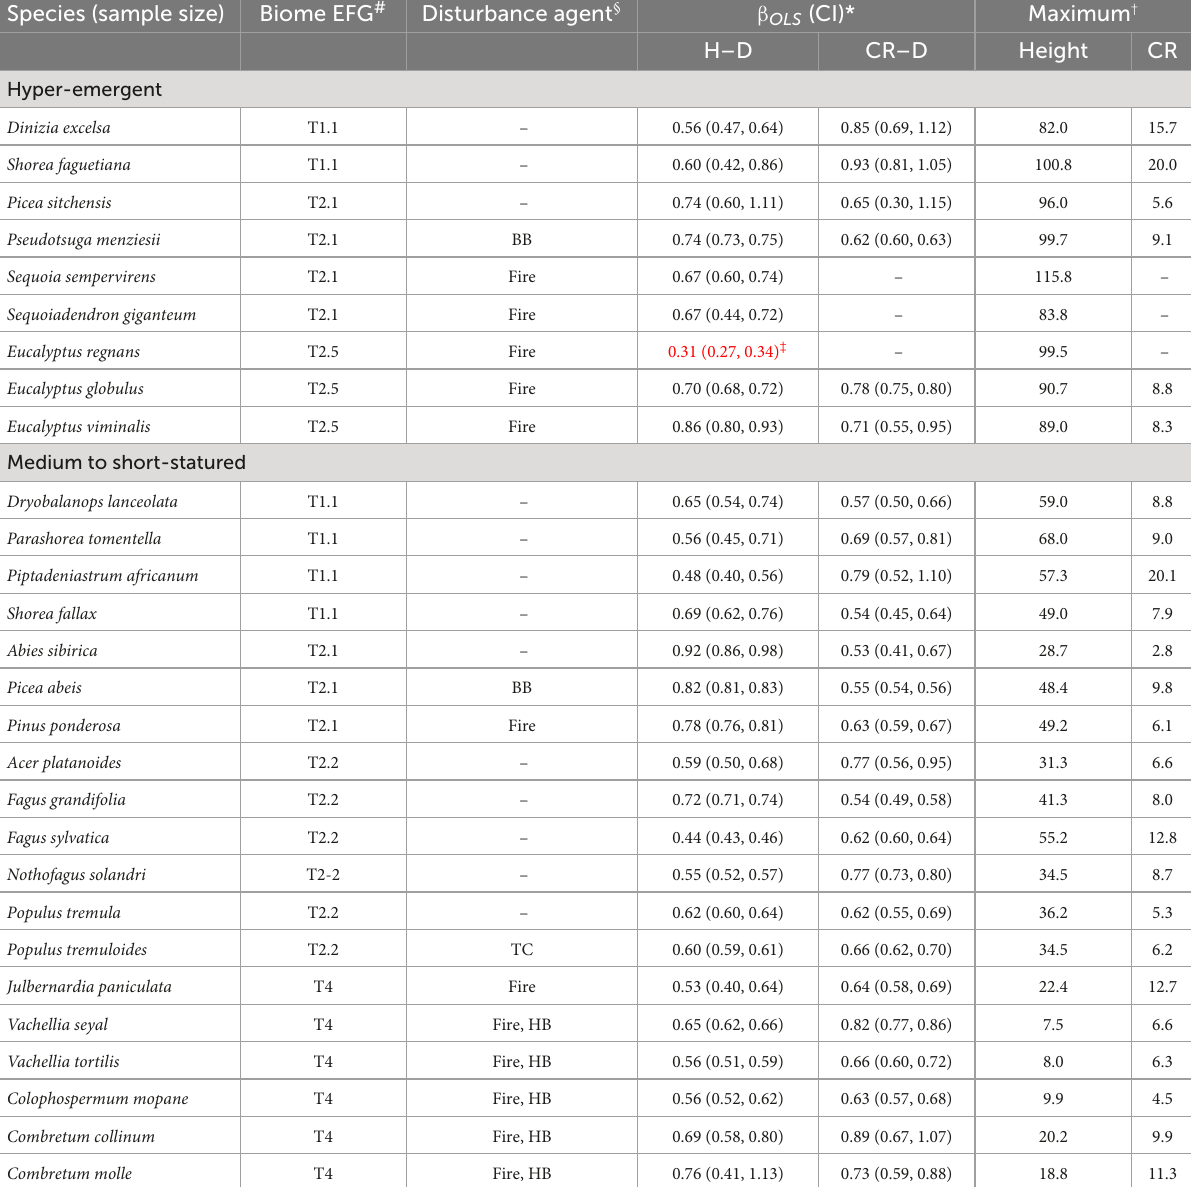
TABLE 5 Comparison of the allometry exponents ( β OLS ) of the stem height to diameter at breast height (H–D) and crown radius to stem diameter (CR–D) scaling in nine of the world’s tallest and hyper-emergent tree species with medium to shorter tree species in different biomes. Species (sample